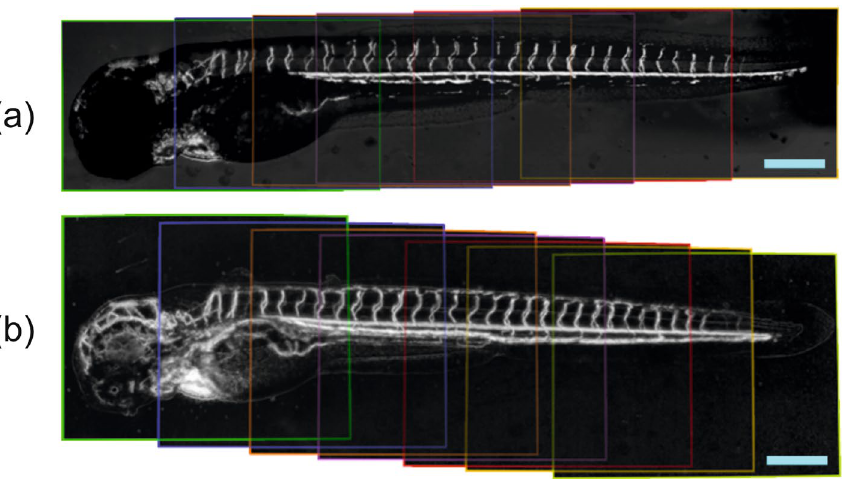
Figure 4. Panoramic vessel images in VISNIR ( a ) and SWIR ( b ). Scale bar: 0.5 mm. Color frames demonstrate the areas of the images from the initial